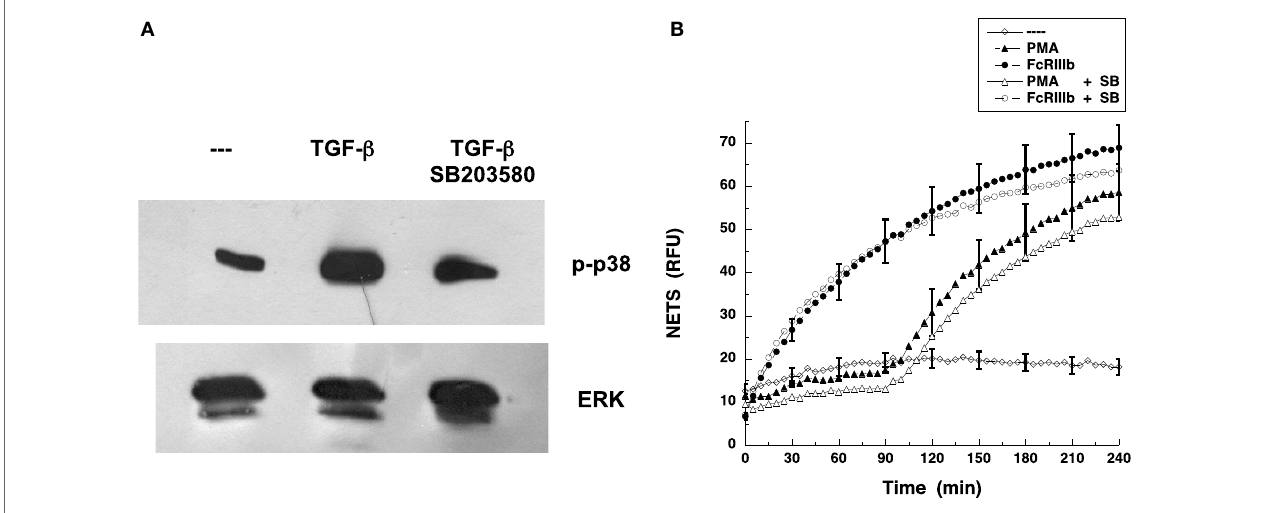
FigUre 8 | p38 MaPK is not required for Fc γ riiib-mediated neT formation . (a) Human neutrophils were left untreated (---) or were stimulated with 5 ng/ml transforming growth factor- β (TGF- β ). Some neutrophils were previously treated with 100 nM SB 203580, a selective inhibitor of p38 MAPK. Cell lysates were prepared after stimulation. Proteins were resolved by SDS-PAGE, and then Western blotted for phosphorylated-p38 (p-p38) (upper panel) and for total ERK (lower panel). Data are representative of three separate experiments. (B) human neutrophils were left untreated (---), or were stimulated with 20 nm phorbol 12-myristate 13-acetate (PMA), or by cross-linking Fc γ RIIIb with mAb 3G8, and then incubated for 4 h. Some neutrophils were previously treated with 100 nM SB 203580 (SB) (open symbols). The relative amount of NETs was estimated from SYTOX ® Green fluorescence in relative fluorescent units (RFU) every 5 min. Data are mean ± SEM of three experiments done in